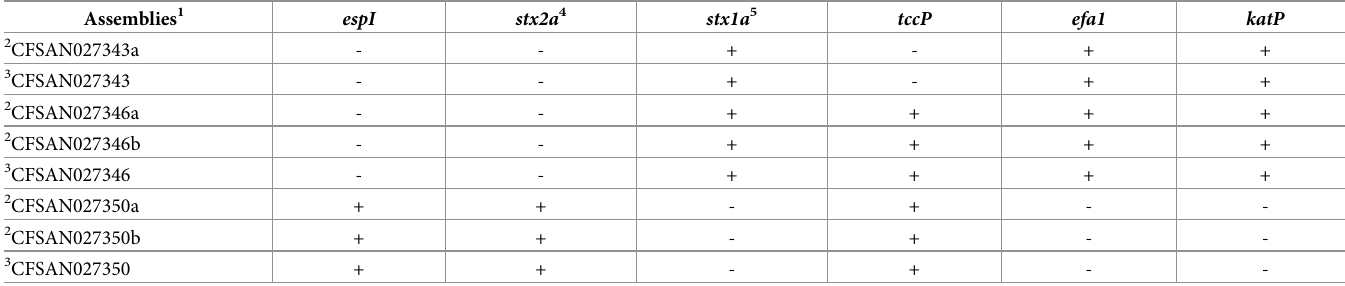
All assemblies were positive for astA , cif , eae , ehxA (plasmid), espA , espB , espF , espJ , espP (plasmid), gad , iha , iss , lpfA , nleA , nleB , nleC , tir , and toxB (plasmid) genes. 1 Runs: a) first, and b) second run. 2